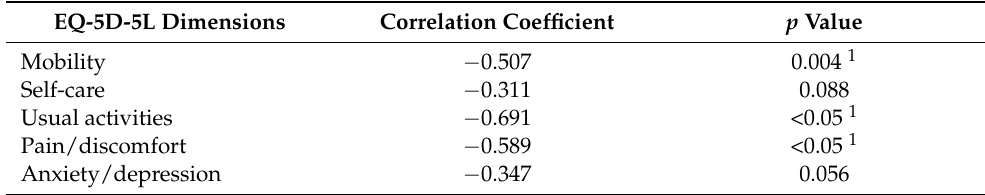
Table 3. Correlation between EQ-VAS with the five dimensions of the EQ-5D-5L. EQ-5D-5L Dimensions